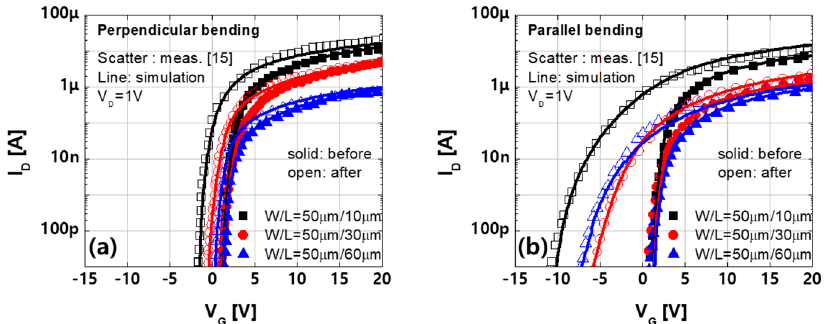
Figure 9. Measured (symbol) and simulated (line) transfer characteristics of the devices with various channel lengths of 10 µm, 30 µm, and 60 µm before and after ( a ) perpendicular bending and ( b ) parallel bending (V D = 1 V). Table 2. Density of states of the parameters of the a-IGZO layer for fitting the measurements before and after perpendicular bending using the single- and multi-region structures, respectively. Channel Length Status Structure Region Trap NGD 1 Before bending Single-region - Intensive After bending Multi-region Figure 10. Different mechanisms of current flow depending on the bending direction: ( a ) perpen- Extensive dicular bending and ( b ) parallel bending. 1 Peak level of donor-like Gaussian states. 2 Peak level of acceptor-like Gaussian